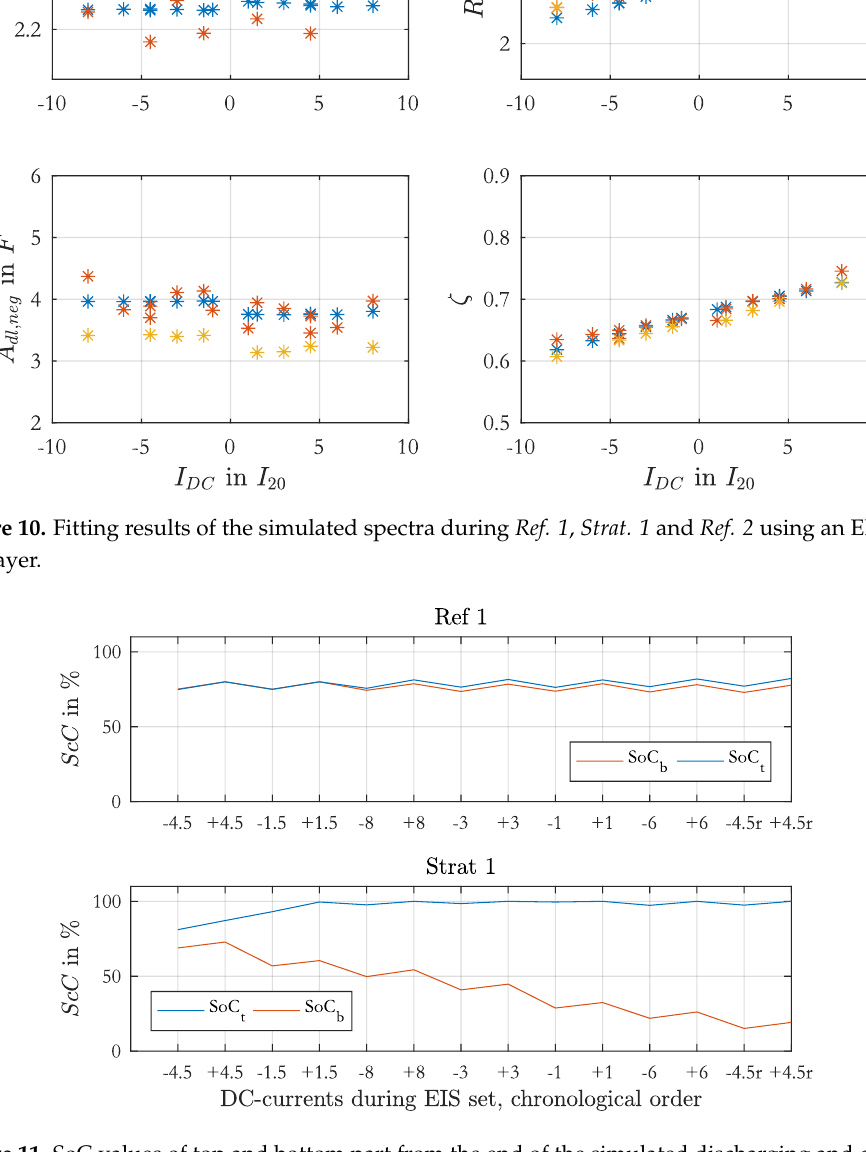
Figure 11. SoC values of top and bottom part from the end of the simulated discharging and charging pulses. The SoC values are plotted over the chronological order of superimposed DC-currents. During Ref. 1 a difference of 4.5% between local SoC arises, while during Strat. 1 the difference is significantly bigger at the end with 80%. During simulation the maximum and minimum SoC was limited to 100% and 0%, hence the SoC of the top part did not increase over 100% after the simulation of the + 1.5 I 20 pulse. The generated SoC difference after Strat. 1 did not change anymore during Ref. 2 . During Strat. 2 this SoC difference further increased to the SoC